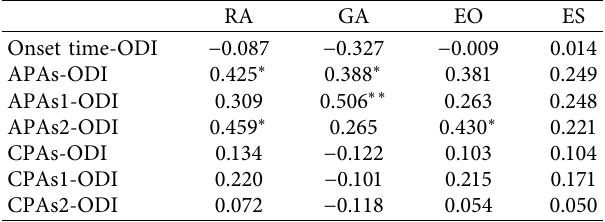
Table 6: Pearson correlation coefficient between ODI scores and muscle onset time/iEMGs in the internal perturbation task.